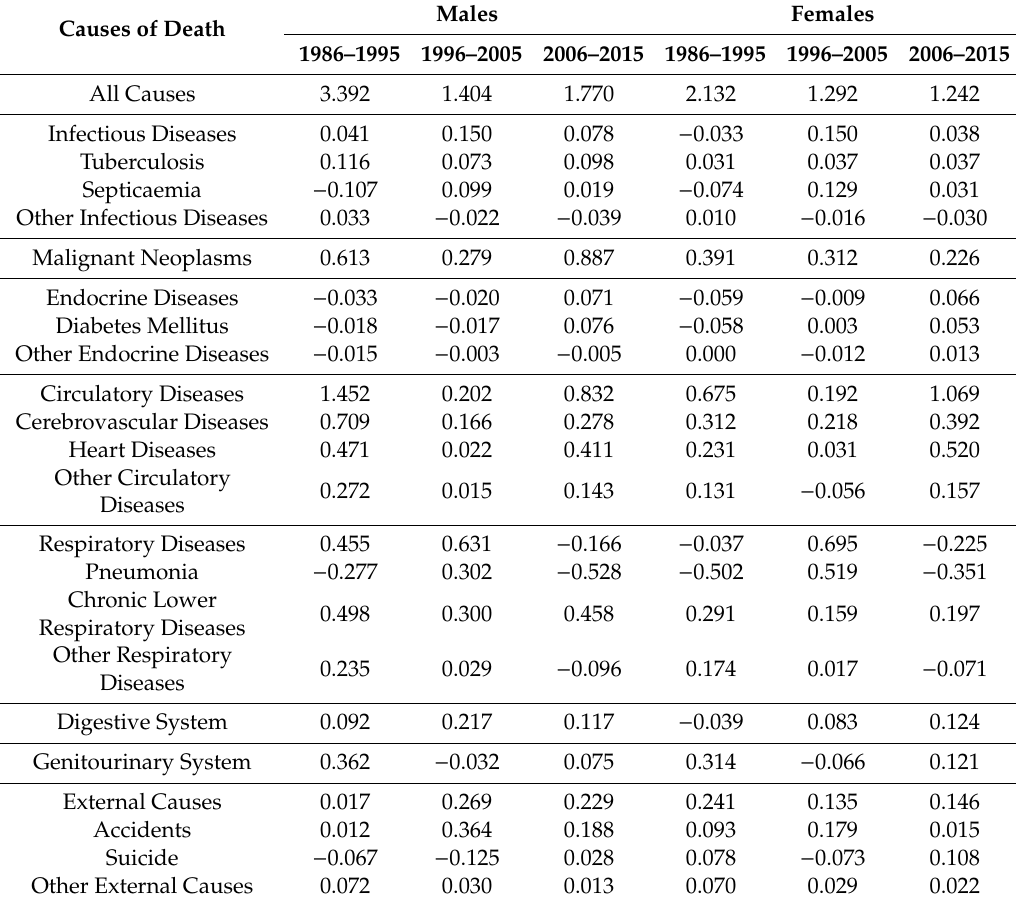
Table 2. Arriaga’s decomposition of the change in life expectancy by major causes of death in 1986–2015 in Hong